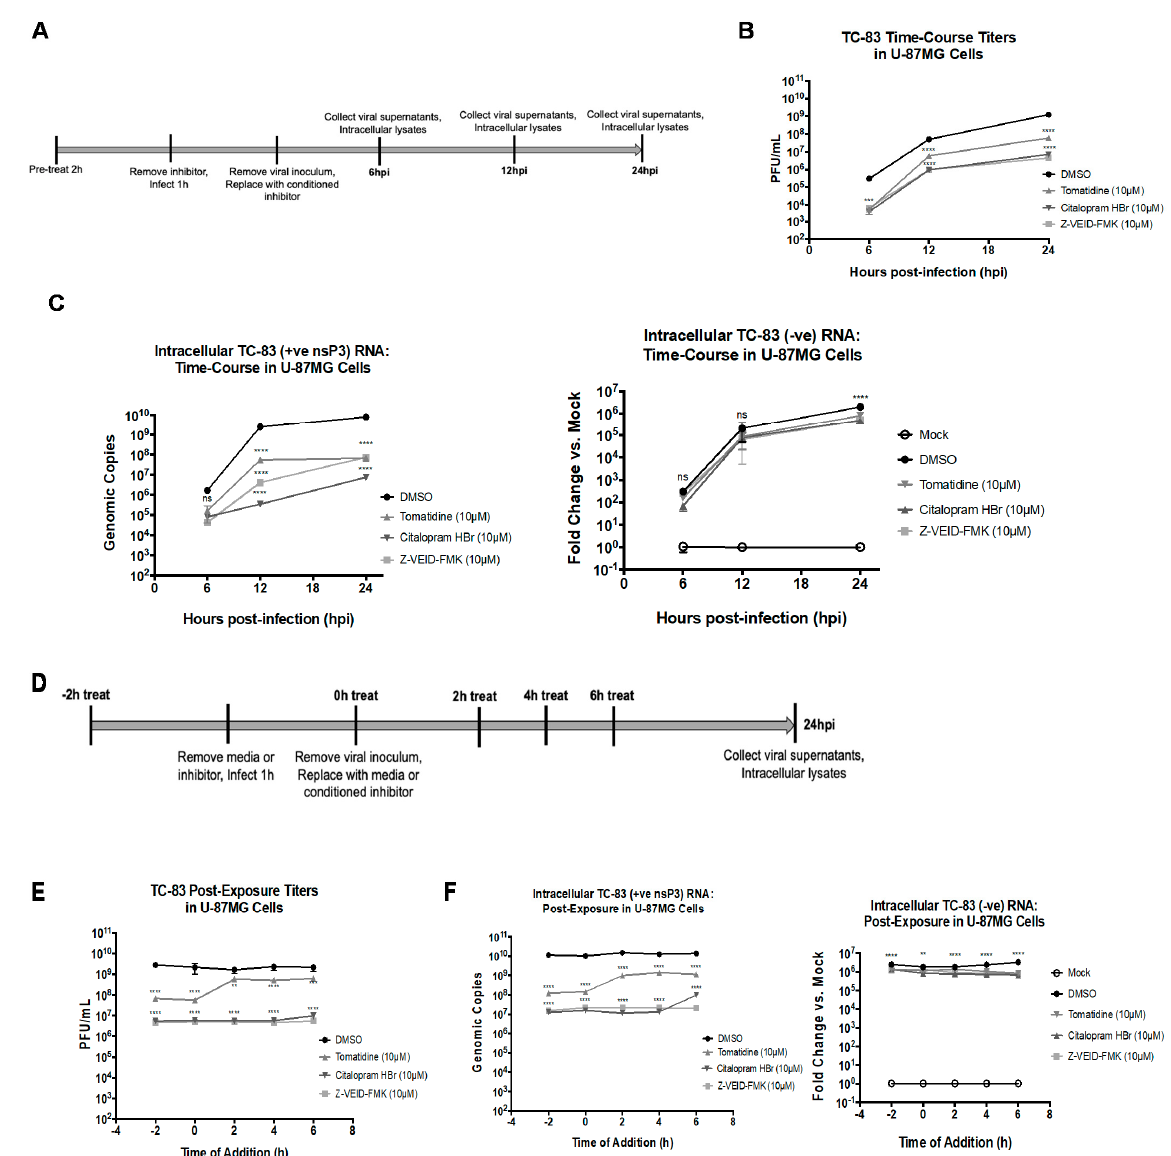
Figure 5. Time-course and post-exposure efficacy against VEEV TC-83. ( A ) U-87MG cells were pretreated for 2 h with nontoxic concentrations of tomatidine, citalopram HBr, and Z-VEID-FMK, subsequently infected with TC-83 at MOI 0.1 for 1 h, and conditioned media were replaced after the removal of viral inoculum. Viral supernatants and intracellular lysates were collected at 6, 12, and 24 hpi. ( D ) U-87MG cells were infected with TC-83 for 1 h at MOI 0.1. Nontoxic con- centrations of tomatidine, citalopram HBr, and Z-VEID-FMK were added after the 1-h infection (0 h) or at 2, 4, 6 h post- infection. A 2-h pretreatment group with all drugs were included as a control. At 24 hpi, viral supernatants and intracel-